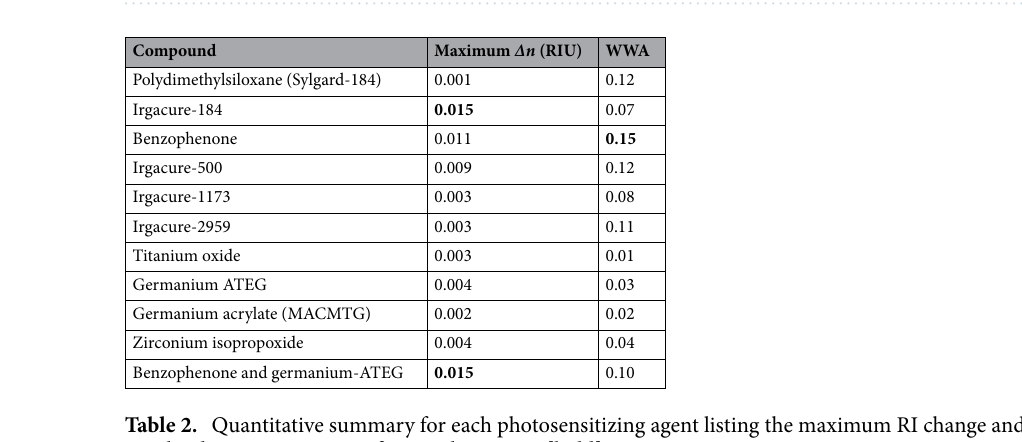
Figure 2. ( a – f ) Fs laser induced refractive index change in PDMS Sylgard-184 for various writing speed and numbers of passes at a given repetition rate. ( f ) Refractive index change evolution relatively to the fluence for one pass by varying the writing speed and/or the repetition rate incrementally.